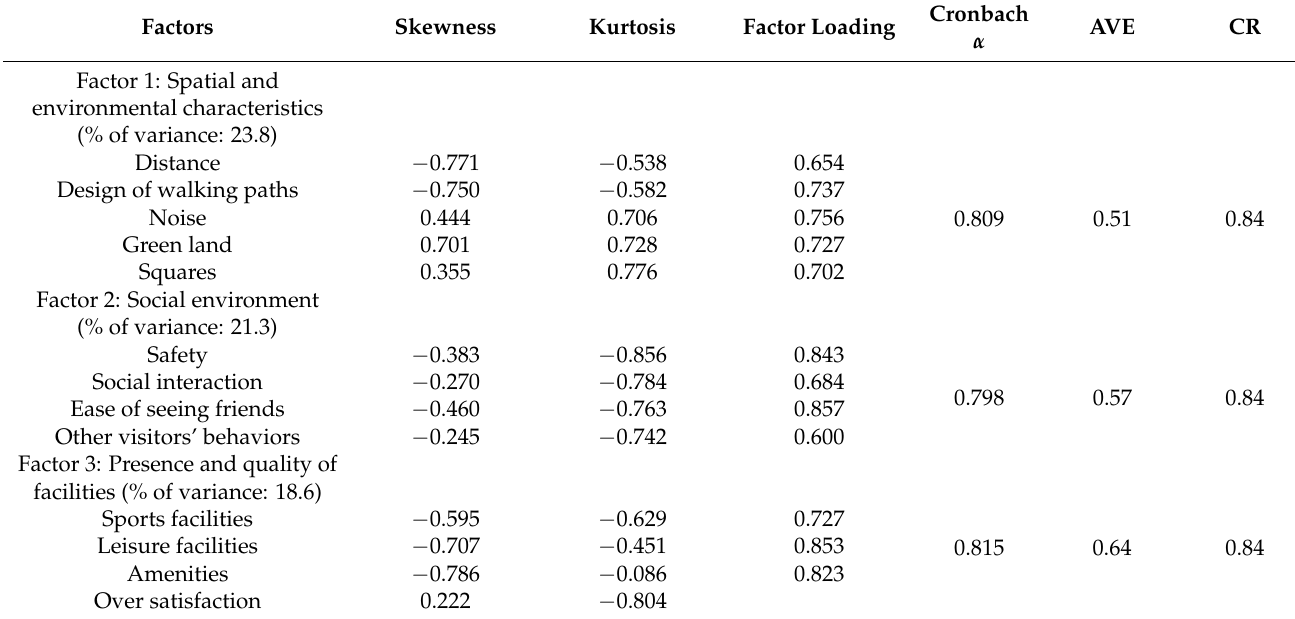
Table 2. Results of exploratory factor analysis, Skewness, and Kurtosis of all